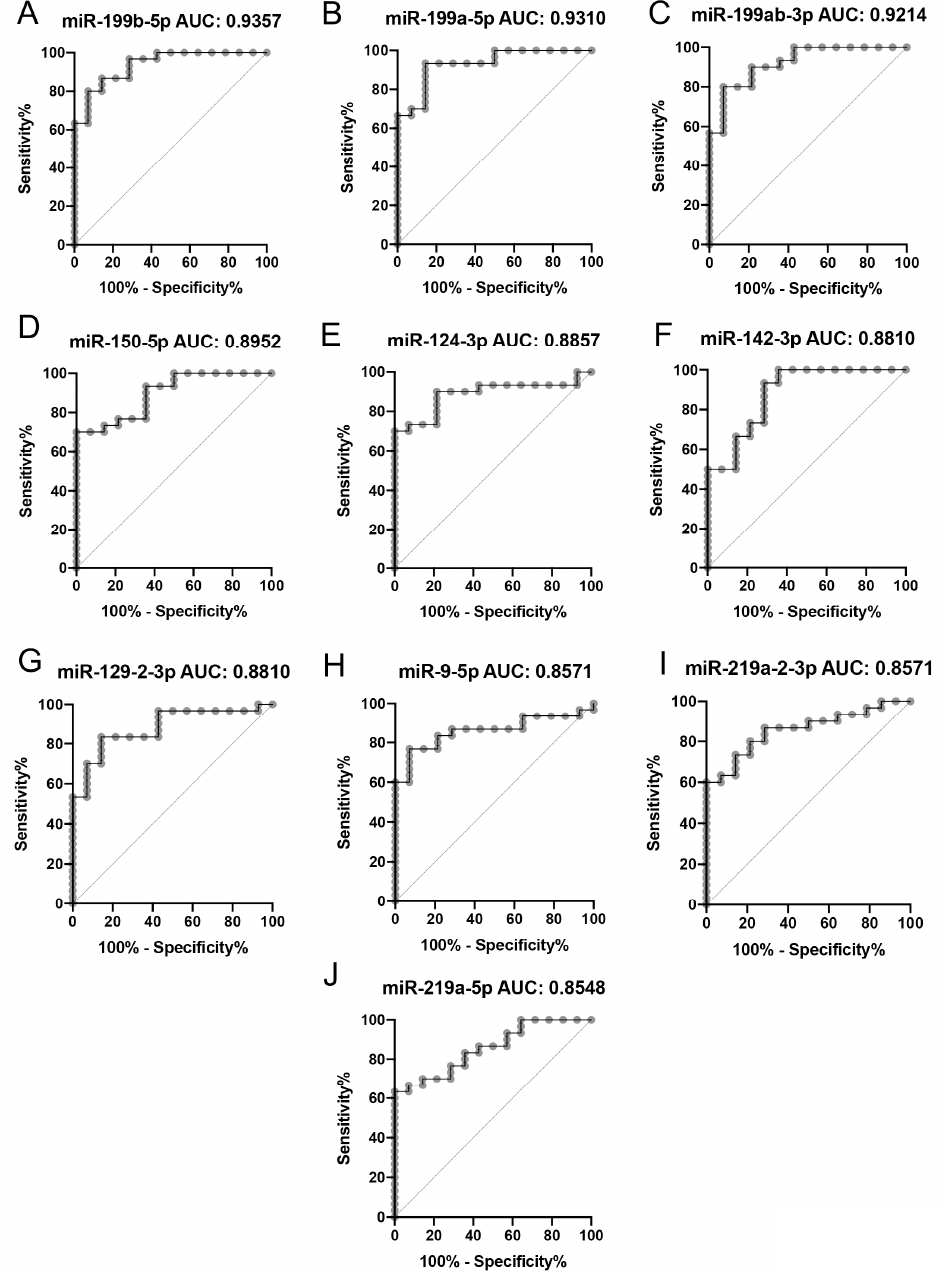
Figure 4. Receiving operating characteristics analysis of differentially expressed miRNAs in primary NSCLC versus brain metastasis. ( A – J ) Individual miRNAs are displayed with declining area under the curve (AUC) values. miRNAs from the miR-199 family displayed the highest diagnostic potential.